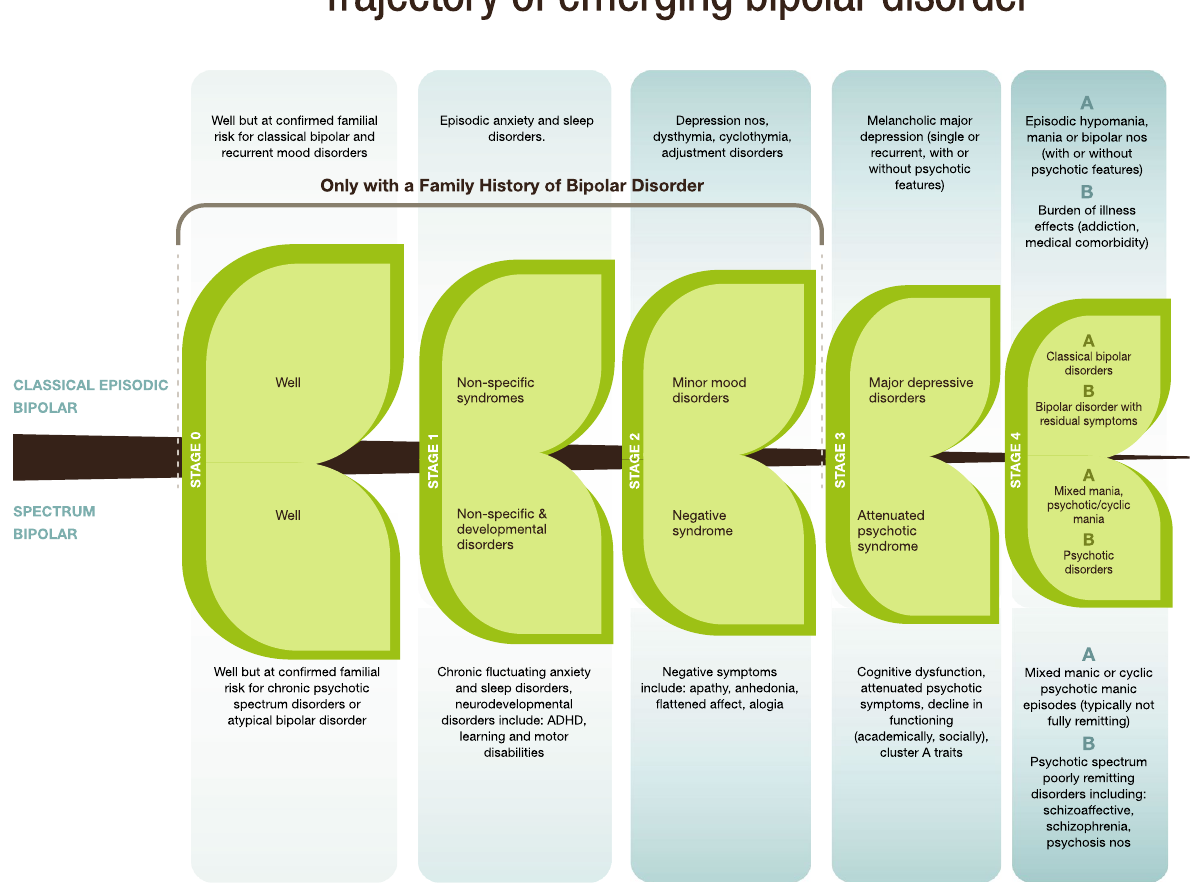
Fig. 1 The trajectory of emerging bipolar disorder in two subtypes of high-risk